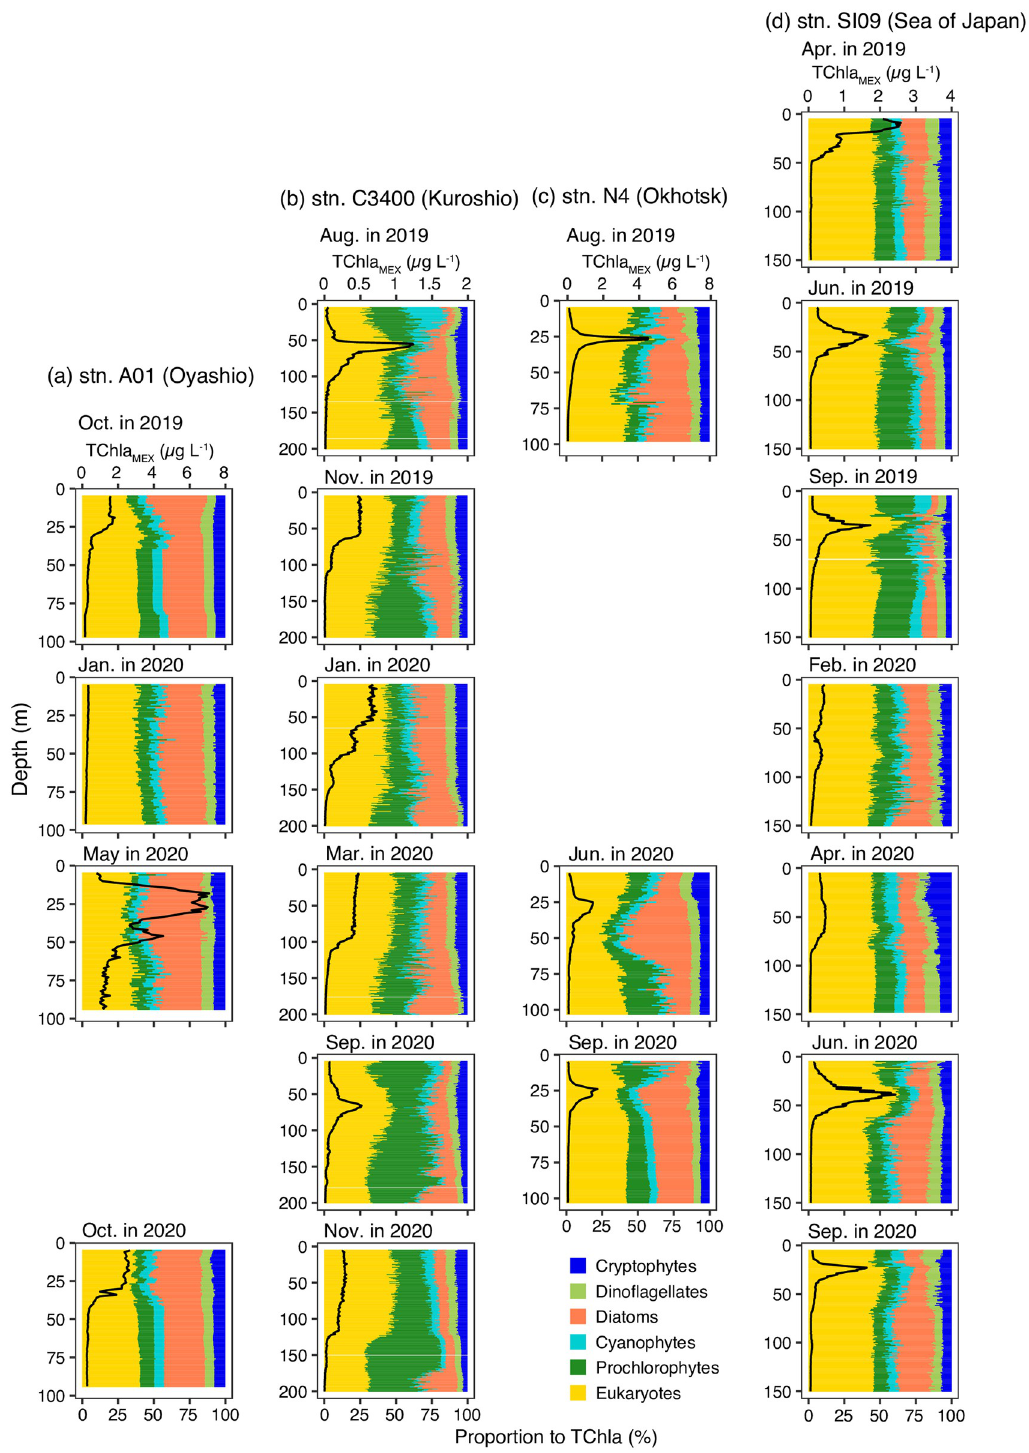
Fig 7. Vertical distributions of MEX (Multi-Exciter)-based chemotaxonomic proportions and TChla concentration. Distributions at (a) stn. A01 in the Oyashio, (b) stn. C3400 in the Kuroshio, (c) stn. N4 in the Okhotsk Sea, and (d) stn. SI09 in the Sea of Japan (JS). The solid black line represents the MEX-based Tchla concentration (Tchla MEX ). The scales of Tchla MEX were the same in every area regardless of the season. The panels were sequenced from spring in 2019 to autumn in 2020. The blank panels indicated that the observations were not conducted at that station in that season and year. At the stn. SI09, vertical profiles were observed twice in the